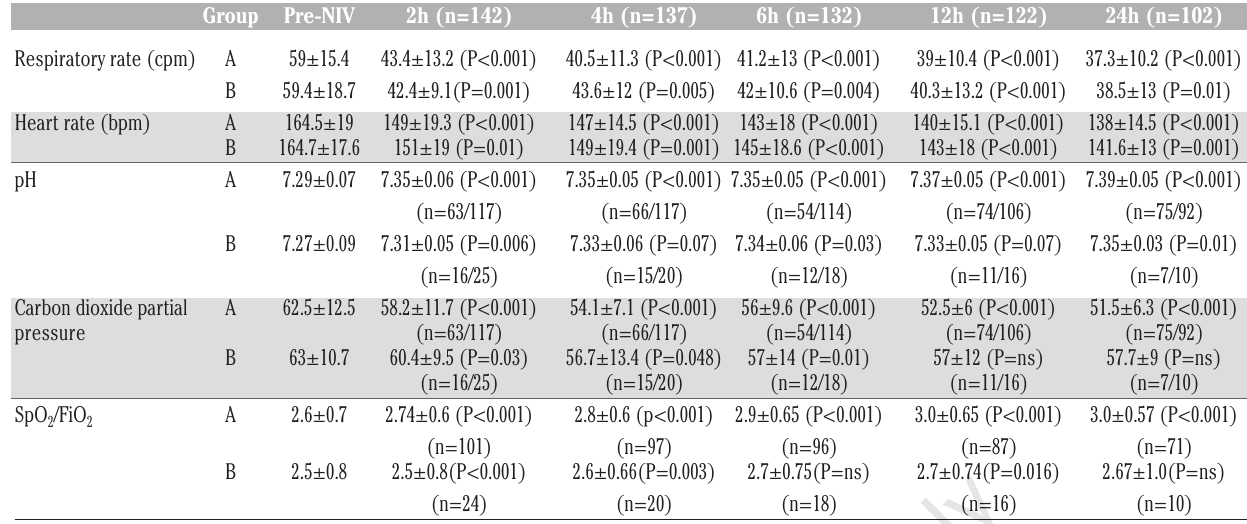
Table 2. Evolution of clinical and gasometric parameters. Clinical evolution for the first 24h: paired T test showed significant improve- ment at 2. 4. 6. 12. and 24 h for all parameters in group A as well as in group B for respiratory and cardiac